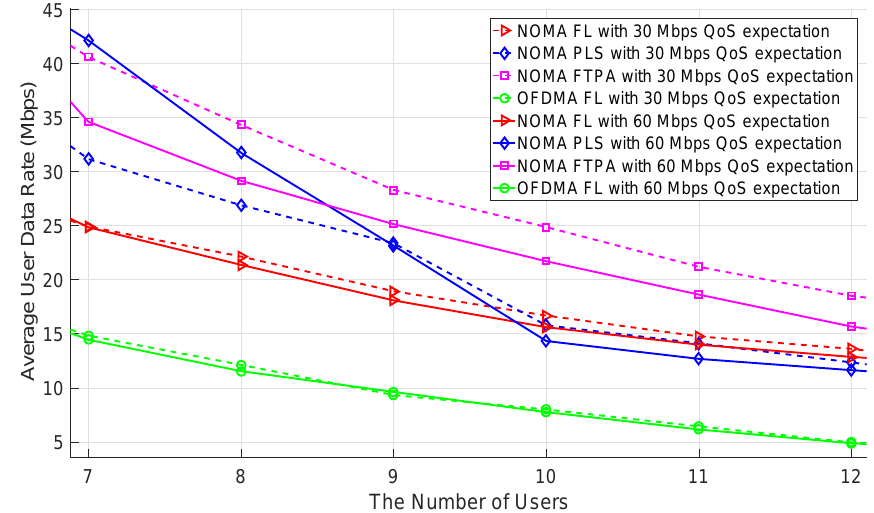
Figure 4. Comparisons of the AUDR in three dimensions with varied users and QoS expectations of 30 Mbps and 60